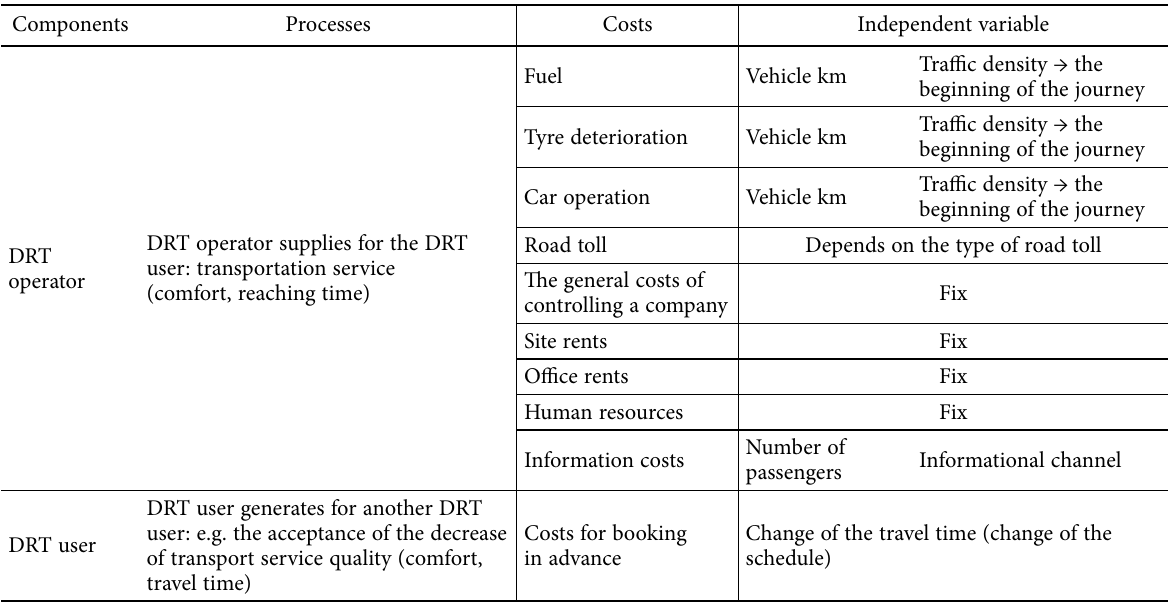
Table 2. Costs generated by the inner elements of the DRT